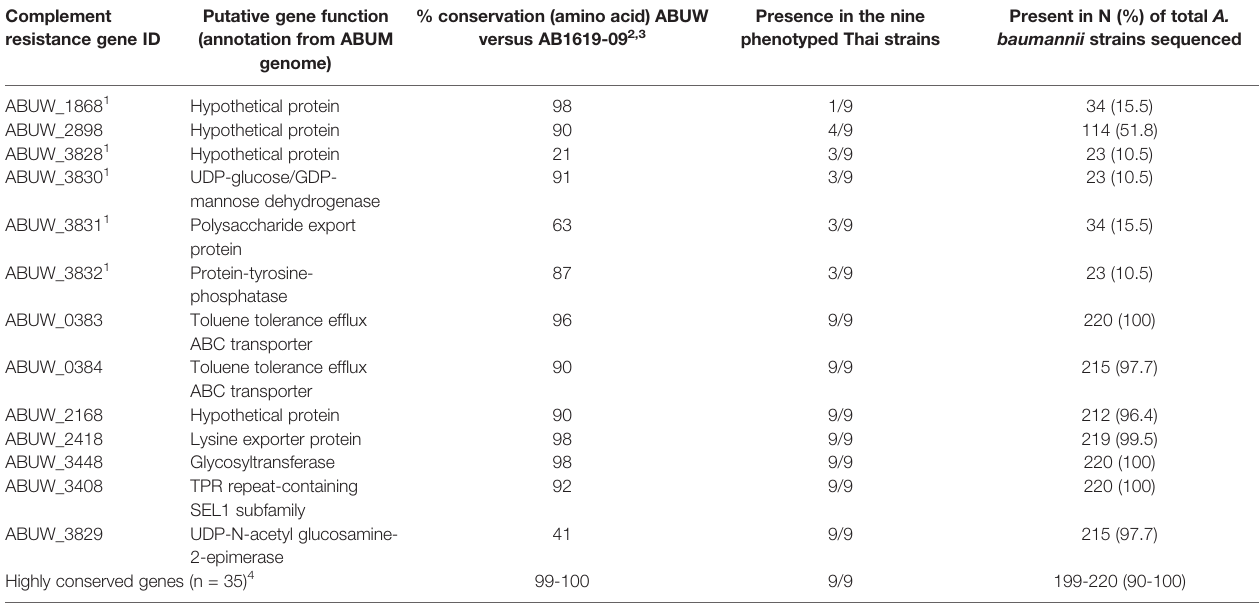
TABLE 2 | Genome data on the distribution of complement resistance genes amongst 220 Thai clinical A. baumannii strains (30). Complement resistance gene